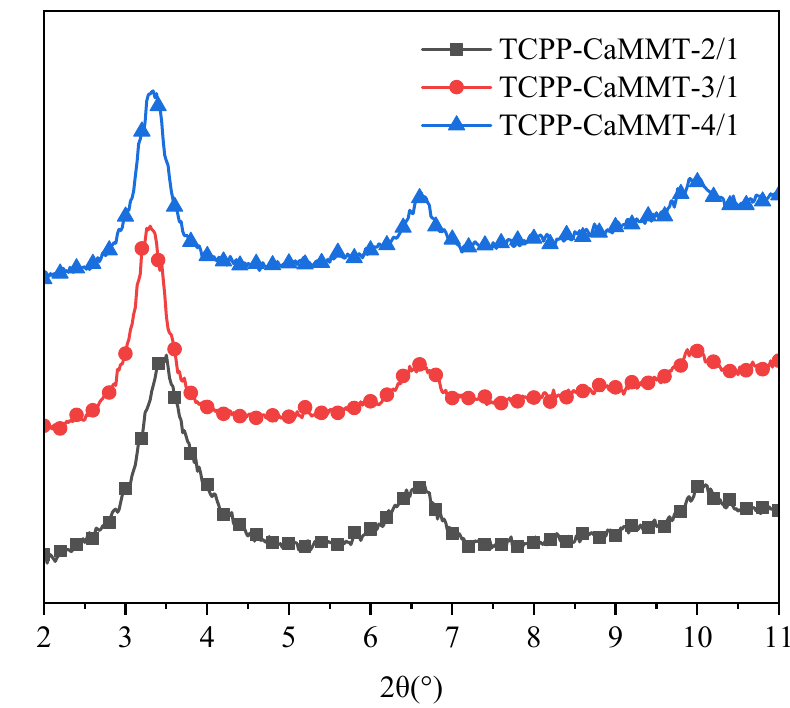
Figure 7. XRD patterns of TCPP-CaMMT nanocompounds.